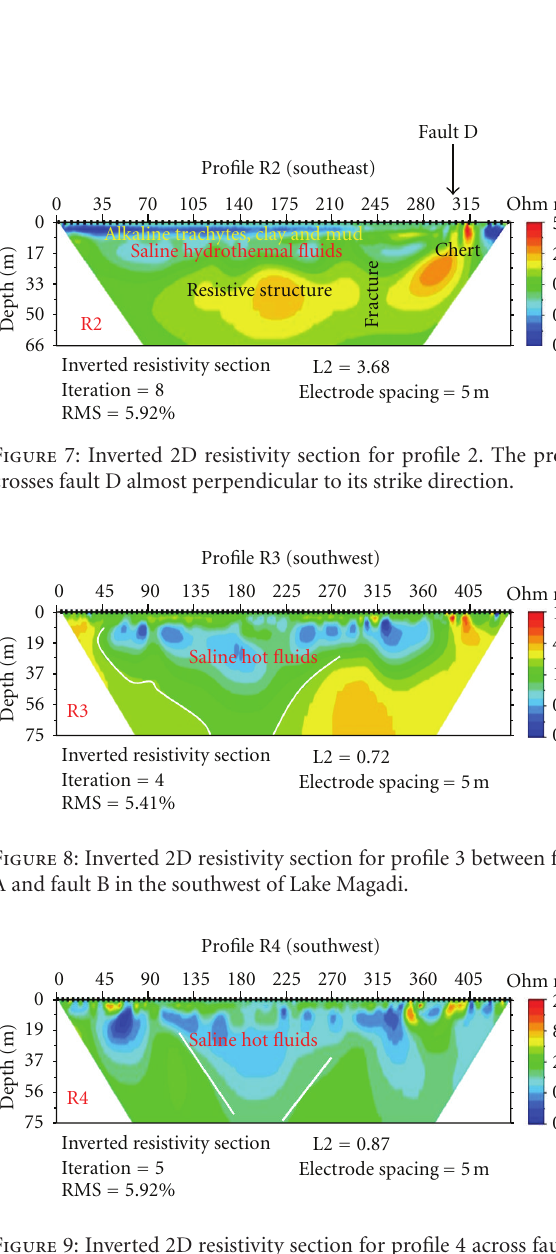
Figure 9: Inverted 2D resistivity section for profile 4 across fault B towards fault A in the southwest of Lake